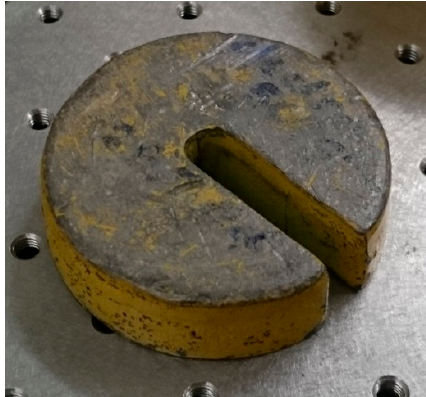
Figure 11. Laboratory membrane experimental setup.